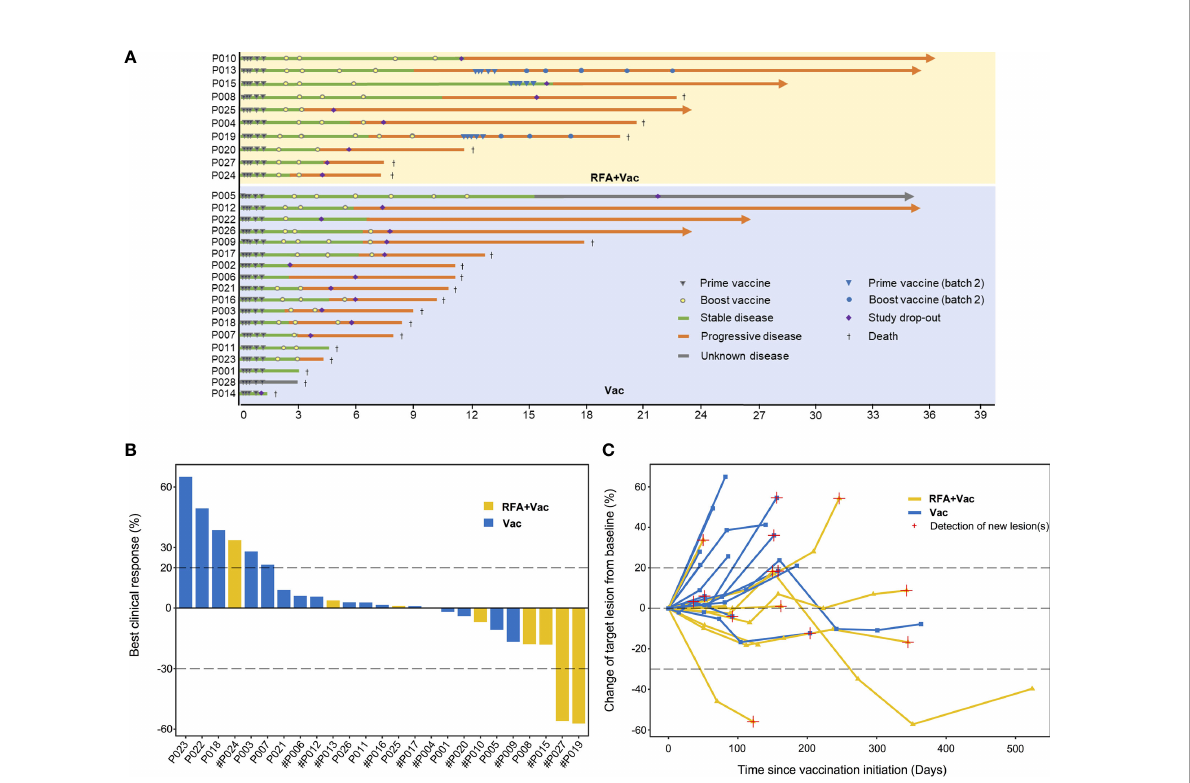
FIGURE 1 Better clinical response in RFA+Vac patients upon receiving iNeo-Vac. (A) Swimmer plots of RFA+Vac patients (with yellow background) and Vac patients (with blue background); (B) Waterfall plots of RFA+Vac patients (shown in yellow) and Vac patients (shown in blue). Dashed line above 20% or below -30% indicate 20% increase ( ≥ 20% is considered as progressive disease) or 30% reduction ( ≤ -30% is considered as partial response) of the sum of the longest diameters of the tumors, respectively. # suggested that new lesion(s) was found; (C) Spider plots of RFA+Vac patients